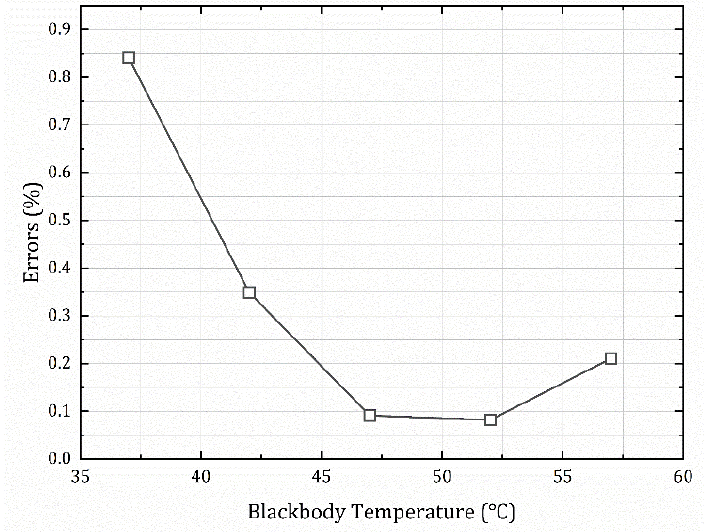
Figure 11. The errors (1 ms) between the processed data of the two methods. Table 5. The error of calculation results of two methods and the actual value. Tem./ ◦ Table 6. Inversion errors of different integration times between the ECCF method and the actual value.